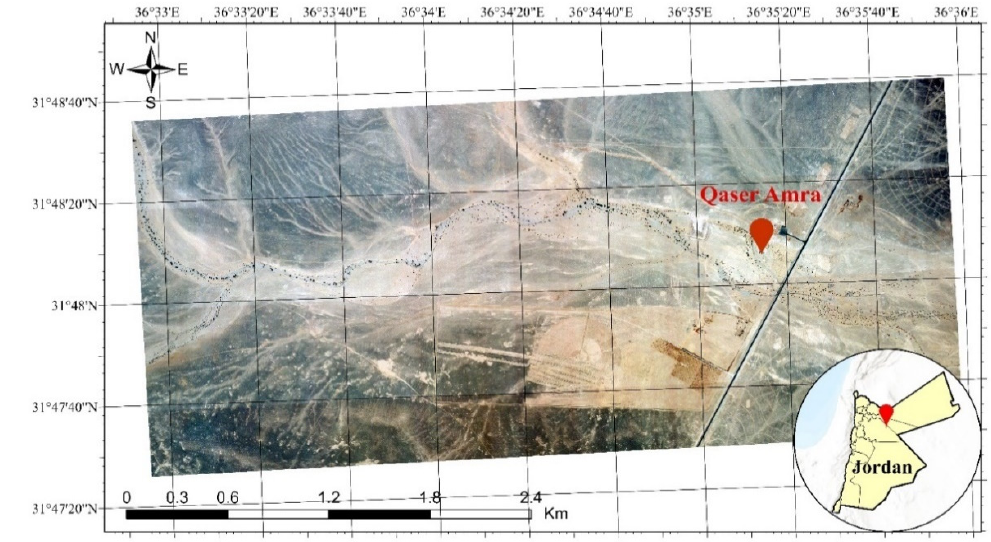
Figure 10. Orthophoto of the Qaser Amra area.